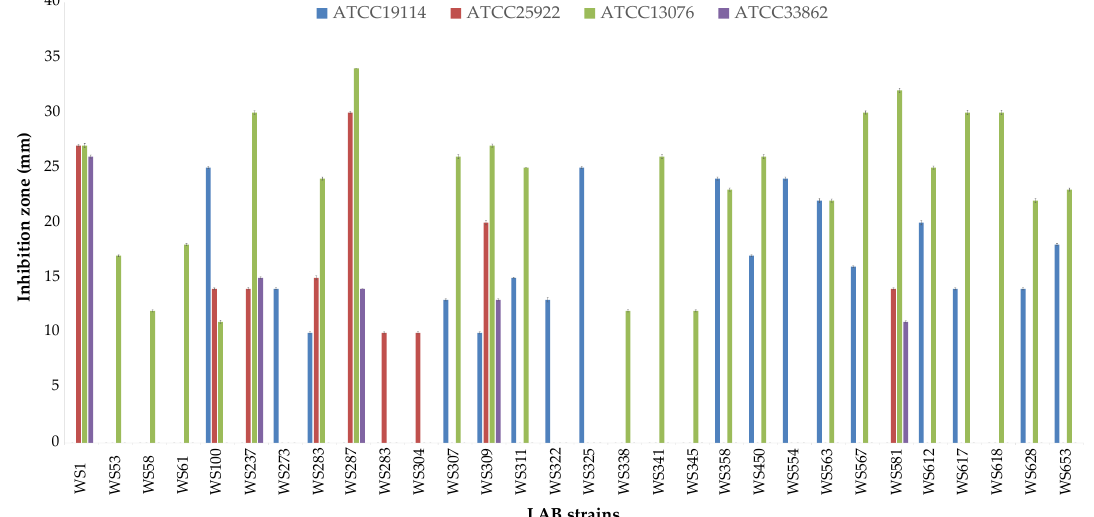
Figure 4. Inhibitory activity of LAB isolated from wooden shelf biofilms. Strain codes belong to the following species: En. faecalis (WS1), En. faecium WS237, WS273, WS283, WS311, WS322, WS325, WS338, WS341, WS345, WS358, WS554, WS563, WS612, and WS653) En. durans (WS304), En. lactis (WS288), En. viikkiensis (WS58), Lc. lactis (WS61), Ln. mesenteroides (WS53, WS307, WS567, WS581, WS618, and WS628), P. pentosaceus (WS287, WS309, and WS450), Lb. delbrueckii (WS100), W. hellenica (WS617), and W. paramesenteroides (WS581).